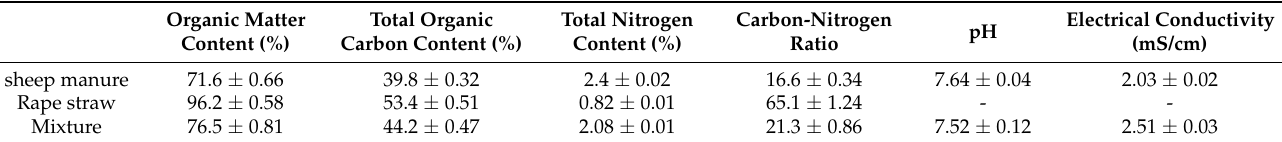
Table 1. Physiochemical properties of composting raw